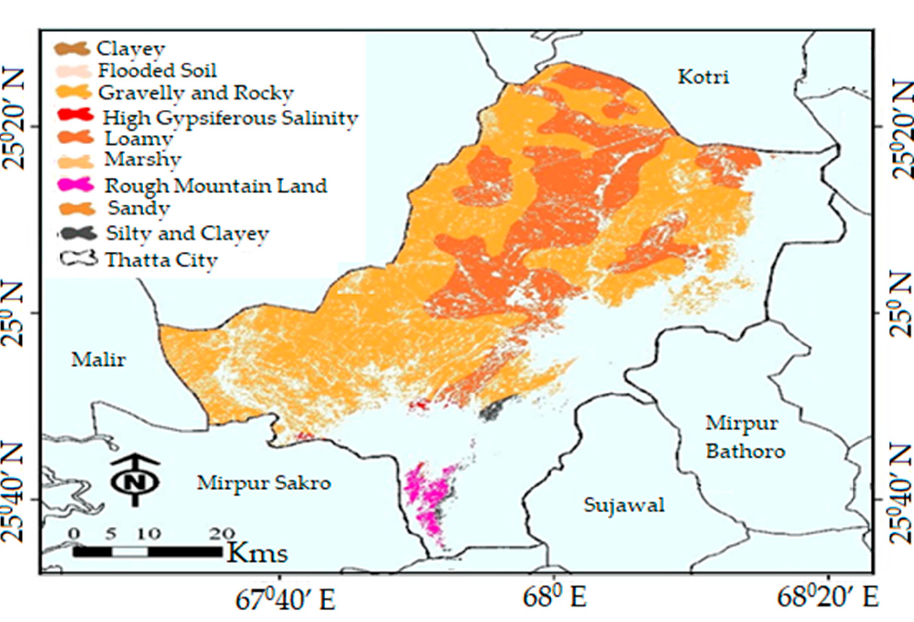
Figure 4. Land cover map of Keenjhar Lake.